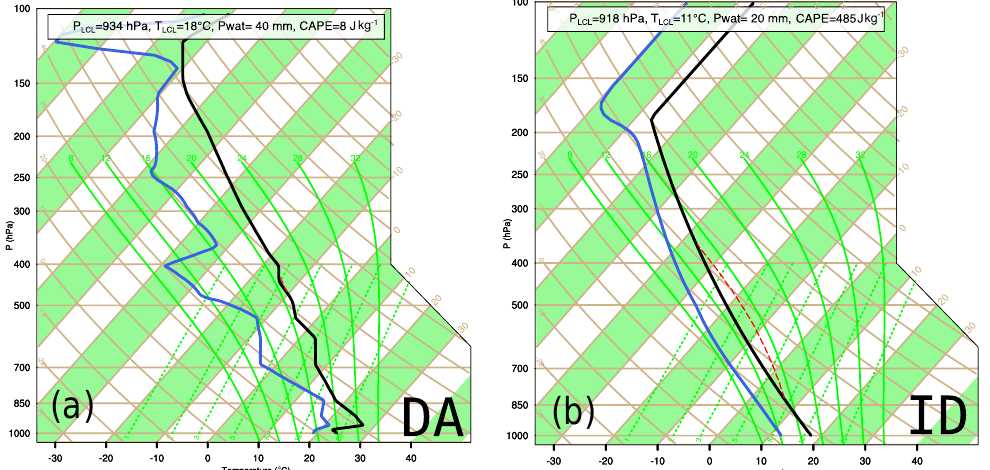
Figure 2. Skew-T diagrams of the two soundings used to initialize the atmosphere in the simulations. (a) Shows the dry soil advantage sounding of Findell and Eltahir (2003), DA , while (b) shows the idealized sounding of Schlemmer et al. (2012), ID . The upper inset in both panels show the value of pressure at the LCL (lifting condensation level), temperature at the LCL, precipitable water and CAPE (convective available potential energy).